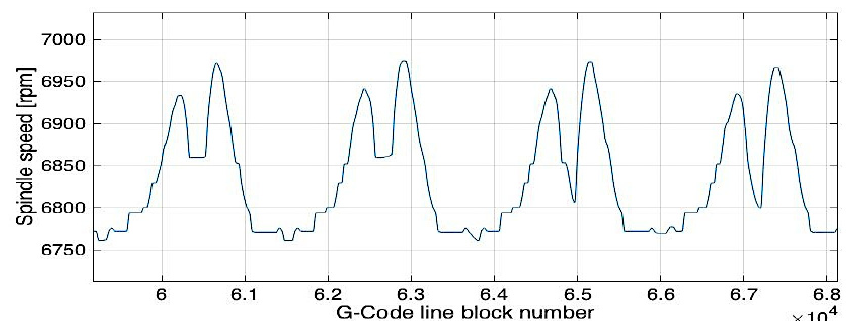
Figure 12. Optimal spindle speeds for optimization strategy B.